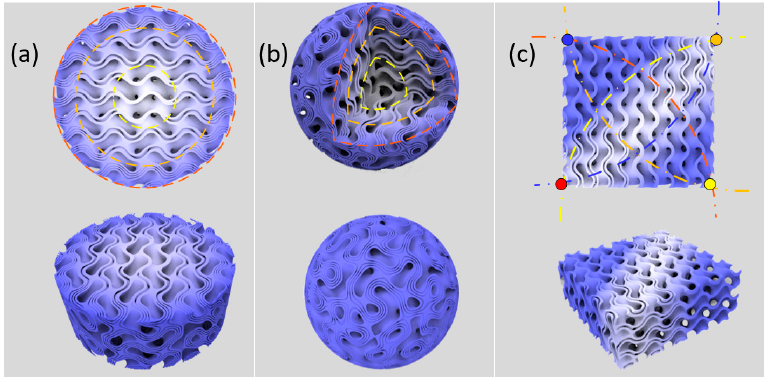
Figure 8. Designs of 2D and 3D functional gradients using the multi-sheet structure: ( a ) 2D gradient of a cylinder; ( b ) 3D gradient of a sphere; and ( c ) 2D heterogeneous design.